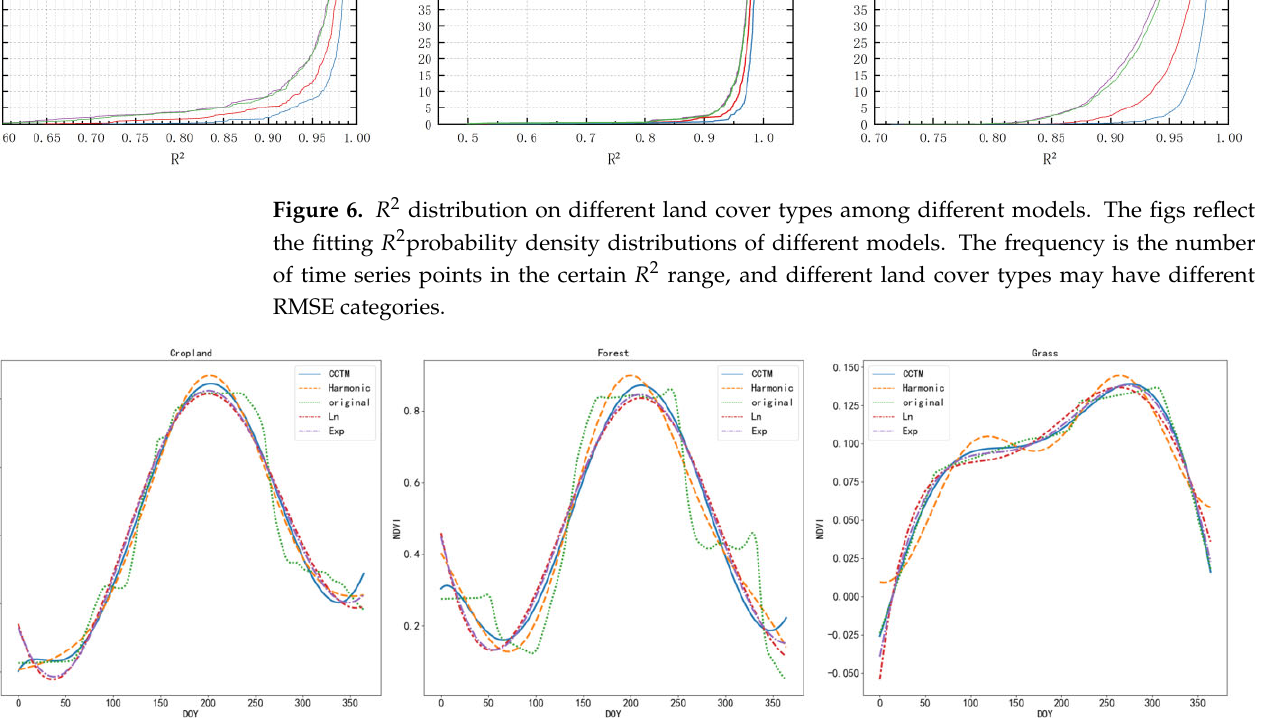
Figure 7. The fitting curves of different models with no seasons division. The figs reflect the yearly time series fitted by the CCTM, Harmonic, Exp, and Ln